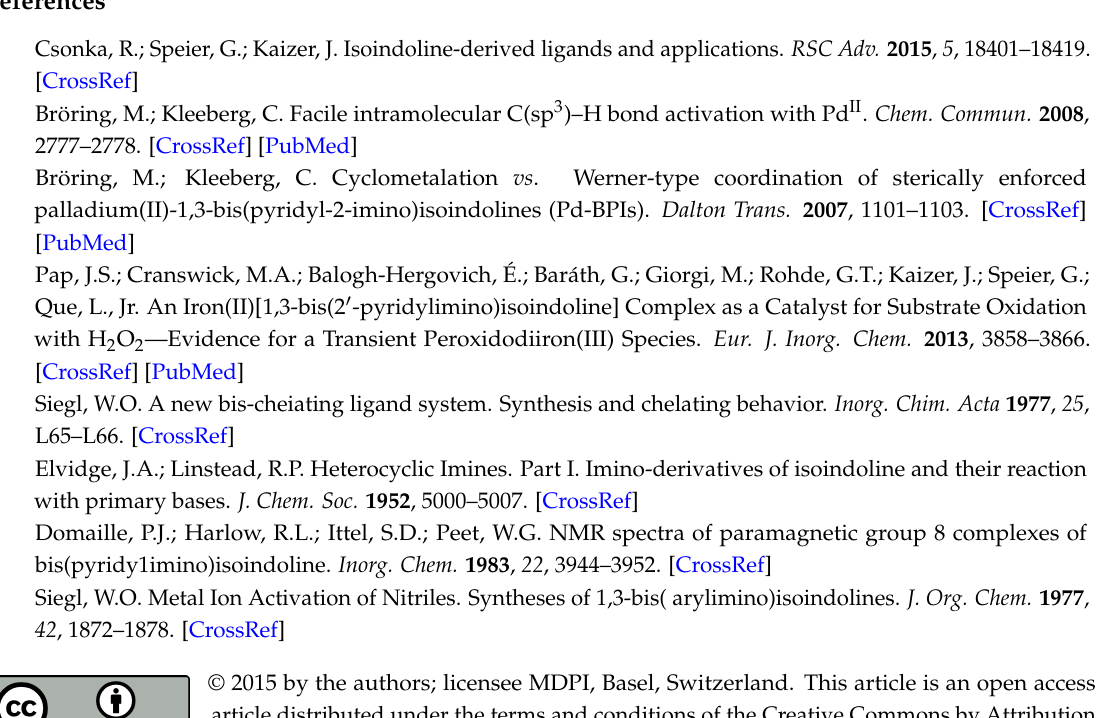
Supplementary Materials: CCDC 1441356 contains the supplementary crystallographic data for this article and can be obtained free of charge from The Cambridge Crystallographic Data Centre via 1 H-NMR, 13 C-NMR and IR spectra are reported in the supplementary materials as Figure S1–S3 together with crystal data and structure refinement parameters as Table S1. They and the molfiles can be found at